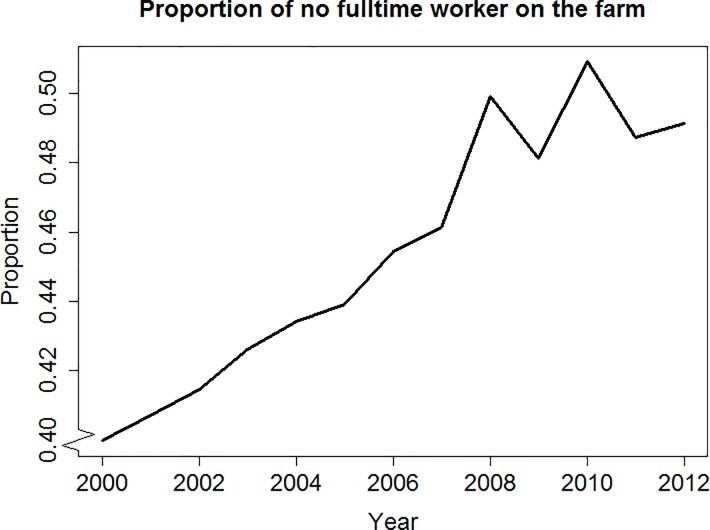
Proportion of Scottish cattle farms with no fulltime worker on the farm (2000–2012).